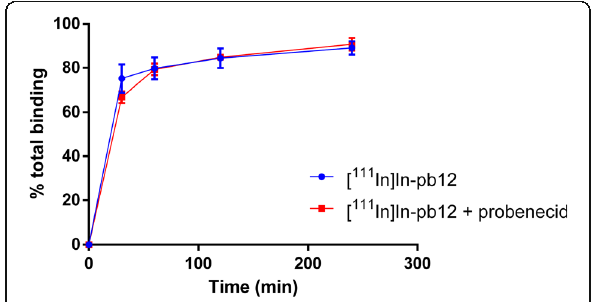
Fig. 6 Investigation of the cellular efflux of [ 111 In]In-pb12 with and without the efflux inhibitor probenecid. Data points represent the mean ± SD of three independent